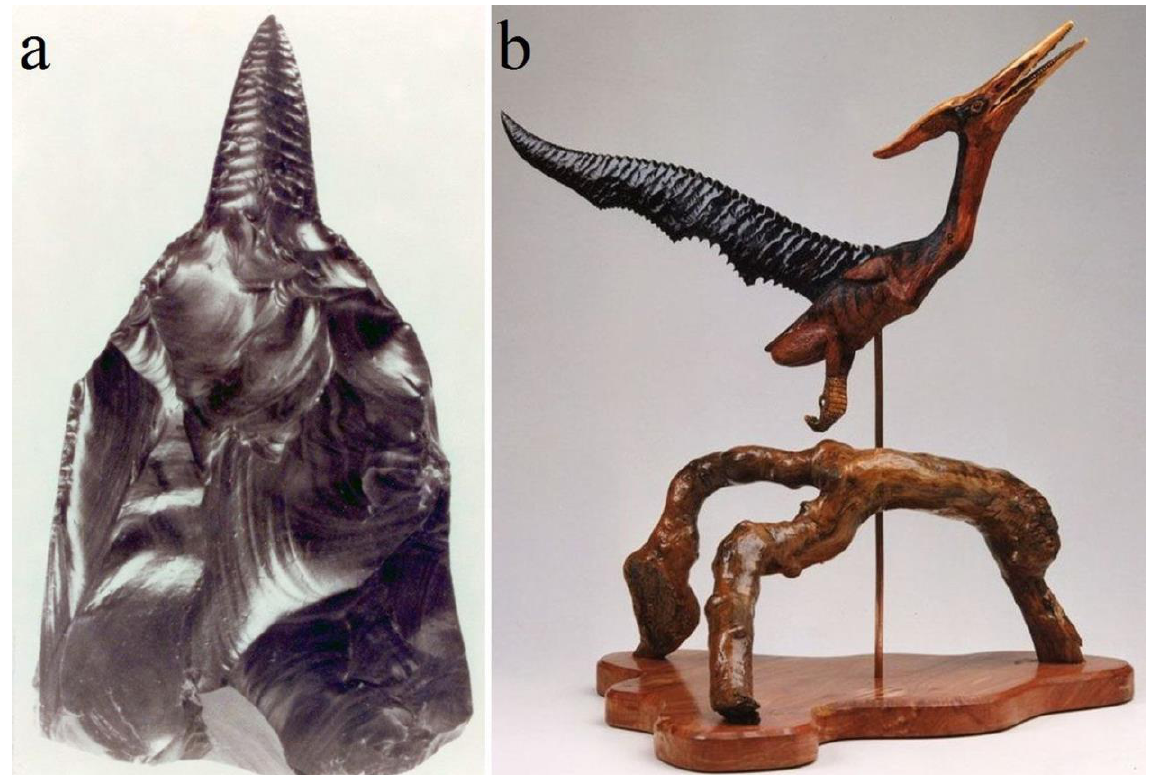
Figure 7. Sculptures/knives made by Errett Callahan. a) Sword in the stone (1996), b) Pterosaur (2002). (Photos from Callahan